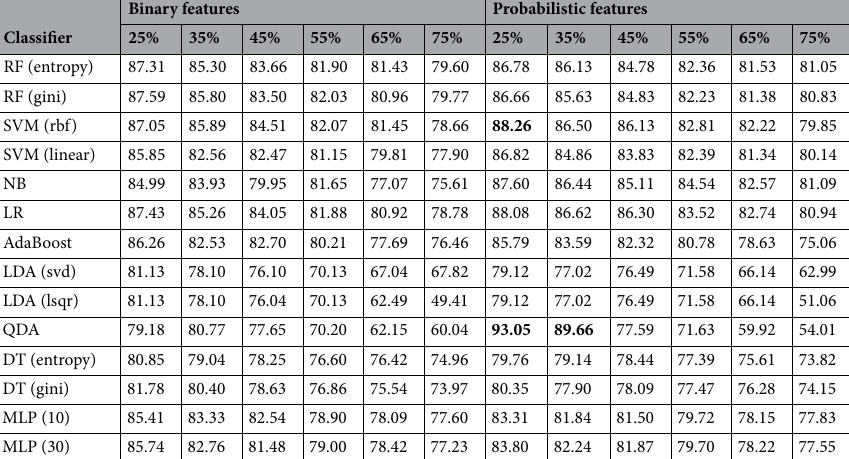
Table 3. Classification accuracy of NeurDNet when only the first-visit tremor assessments are included in the test set. The classification accuracy is measured across different choices of second-stage classifier, including random forests (RF), support vector machines (SVM), Naive Bayes Classifier(NB), logistic regression (LR), AdaBoost classifier (AB), linear discriminant analysis (LDA), quadratic discriminant analysis (QDA), decision trees (DT), and multi layer perceptron